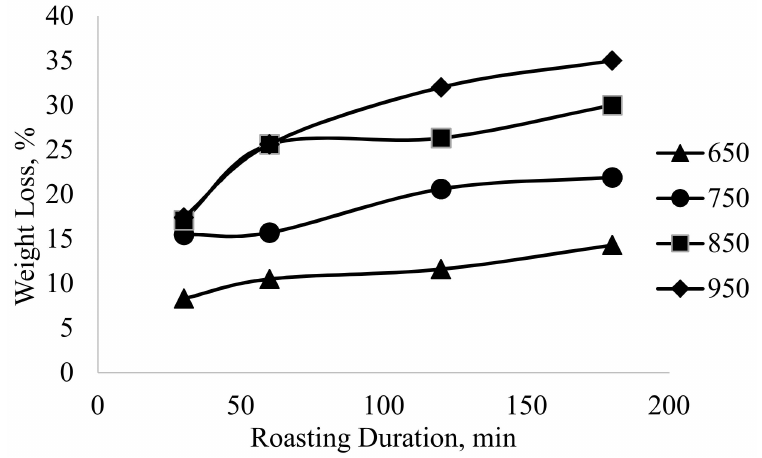
Figure 7. Mass losses at the